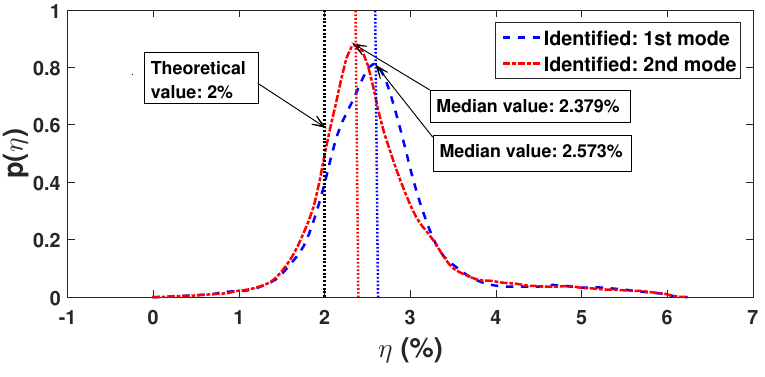
Figure 8. Identified modal